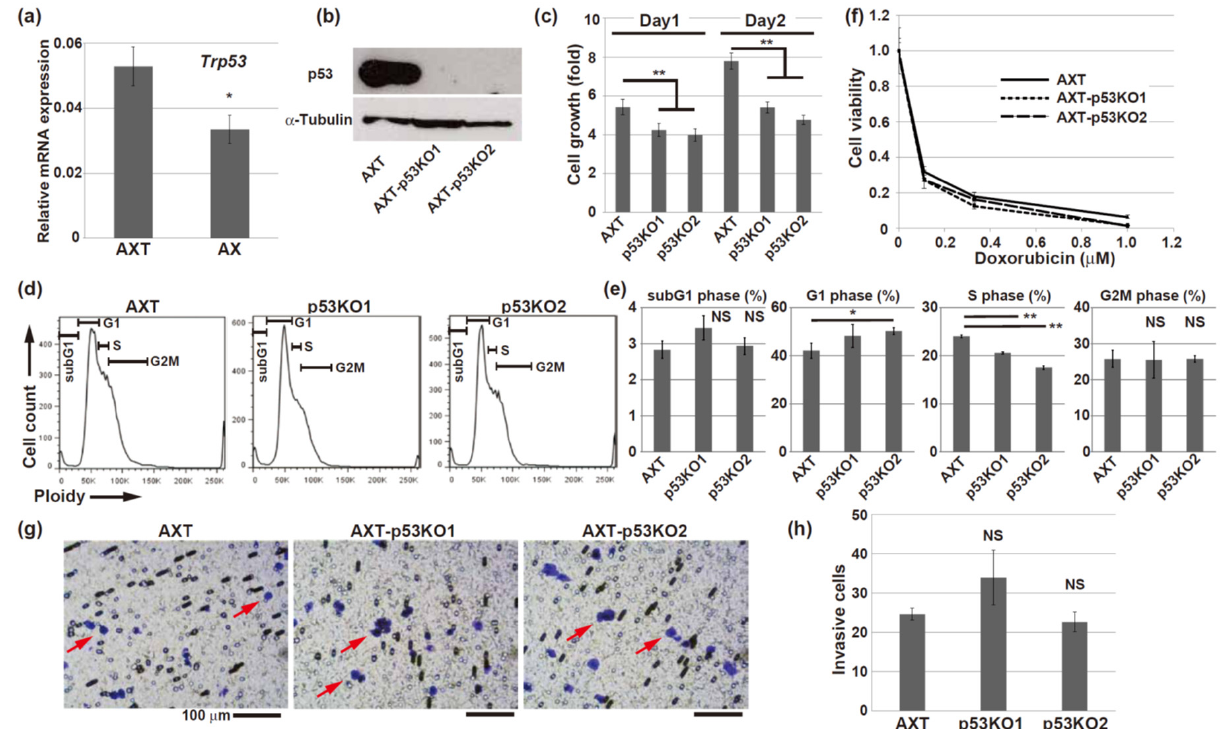
Figure 4. Knockout of R270C mutant p53 did not affect the invasion ability of AXT cells. ( a ) RT and real-time PCR analysis of Trp53 mRNA in AX and AXT cells. The data are normalized to the corresponding levels of Actb mRNA and are shown as the means ± SD of triplicate values. ( b ) Immunoblot analysis of p53 expression using an antibody (#ab90363) in the AXT and p53-knockout AXT cells. ( c ) The growth of the AXT and p53-knockout AXT cells. The ratio relative to the value for day 0 was calculated for each datapoint. ( d , e ) Flow cytometry analysis of DNA content in the AXT and p53-knockout AXT cells. The size of each fraction of cells is shown in ( e ). ( f ) The viability of the AXT and p53-knockout AXT cells was assessed after 2-day exposure to the indicated concentrations of doxorubicin. ( g , h ) Microscope images of the invasion assay using the AXT and p53-knockout AXT cells. Representative purple-stained cells are indicated with arrows. The mean number of invasive cells counted in three different fields of each transwell in triplicate experiments is shown in ( h ). (* p < 0.05; ** p < 0.005; NS, not